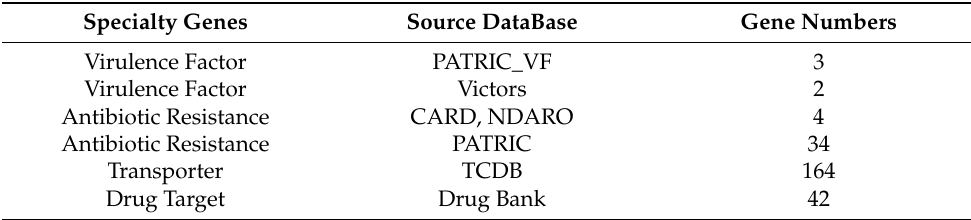
Table 1. Specialty genes in the genome of B. velezensis -VB7.